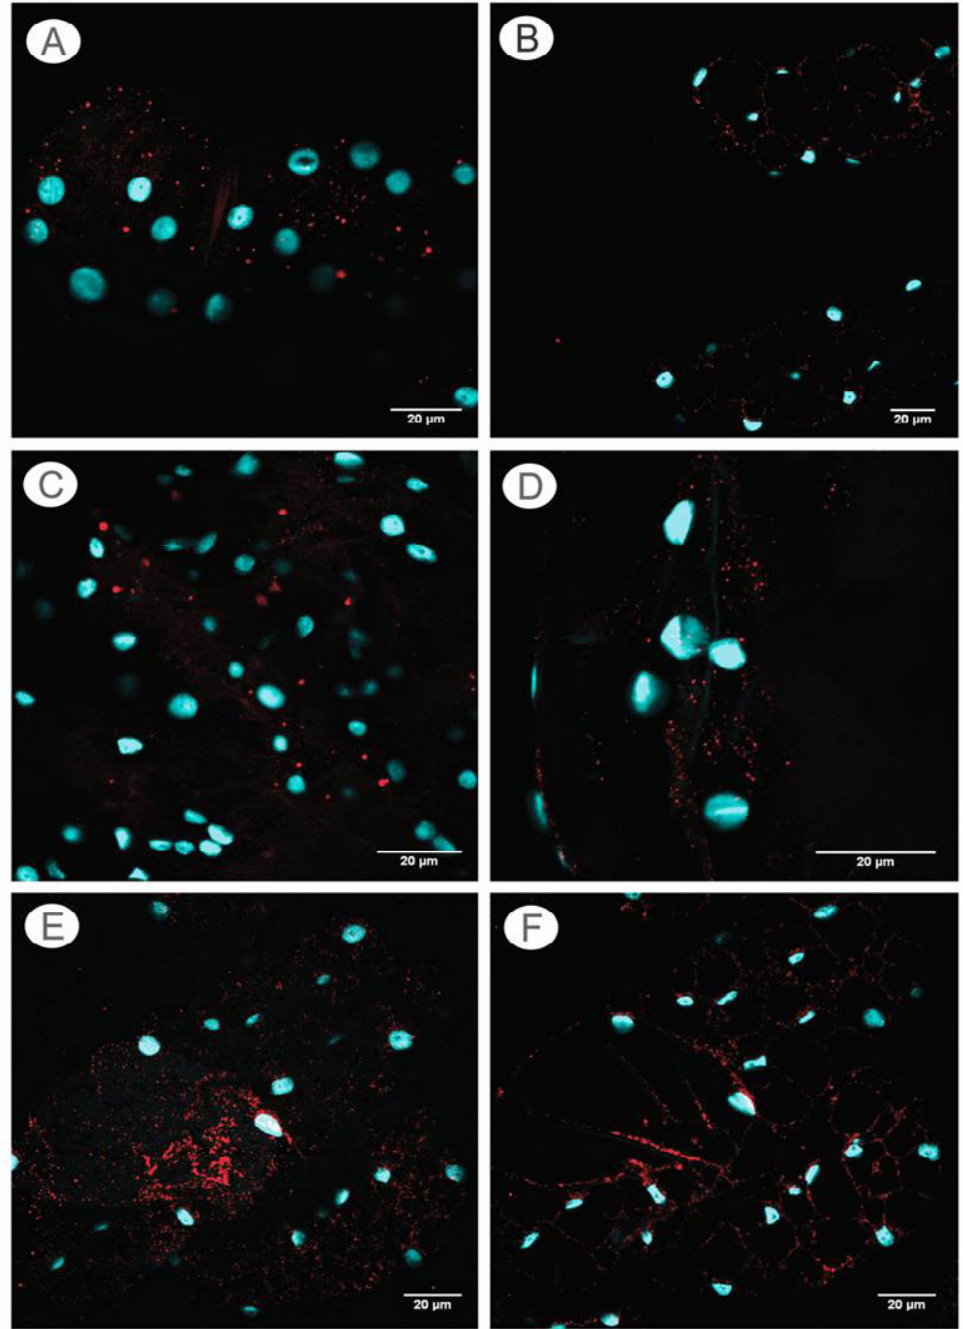
Fig 5 . Confocal microscopy analysis of postpharyngeal glands (PPG) of Atta sexdens rubropilosa workers showing the fluorescence emitted (Cy5) by immunofluorescence of Acyl-CoA dehydrogenase (red) and stained (DAPI) nuclei (blue). A-B. Digitiform prolongation of the PPG of a worker from group FAST 48 h showing nuclei and the low abundance of Acyl-CoA dehydrogenase in gland cells. C-D. Digitiform prolongation of the PPG of a worker from group FAST 120 h showing nuclei and the low abundance of Acyl- CoA dehydrogenase in gland cells. E-F . Digitiform prolongation of the PPG of a worker from group LIPID 48 h showing nuclei and the high abundance of Acyl-CoA dehydrogenase in gland